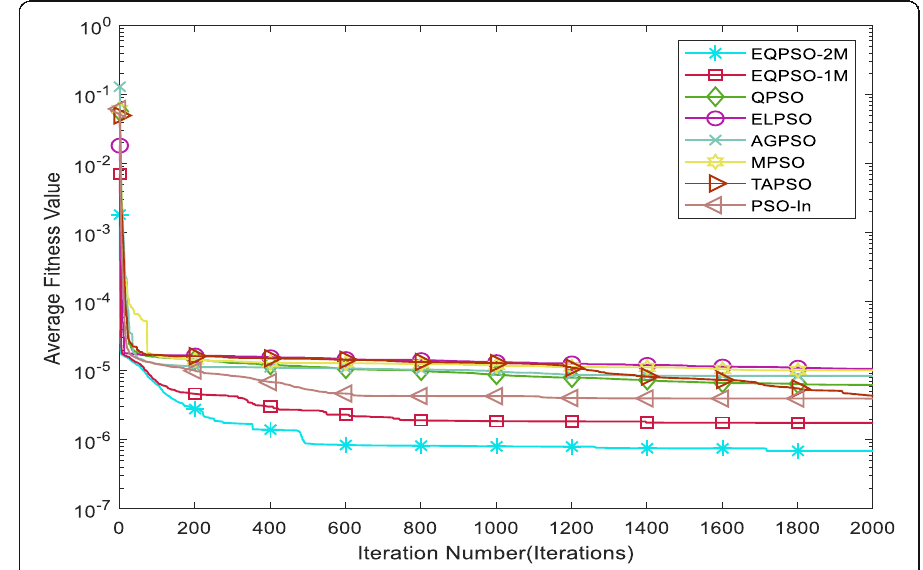
Fig. 7 Average fitness curves for different